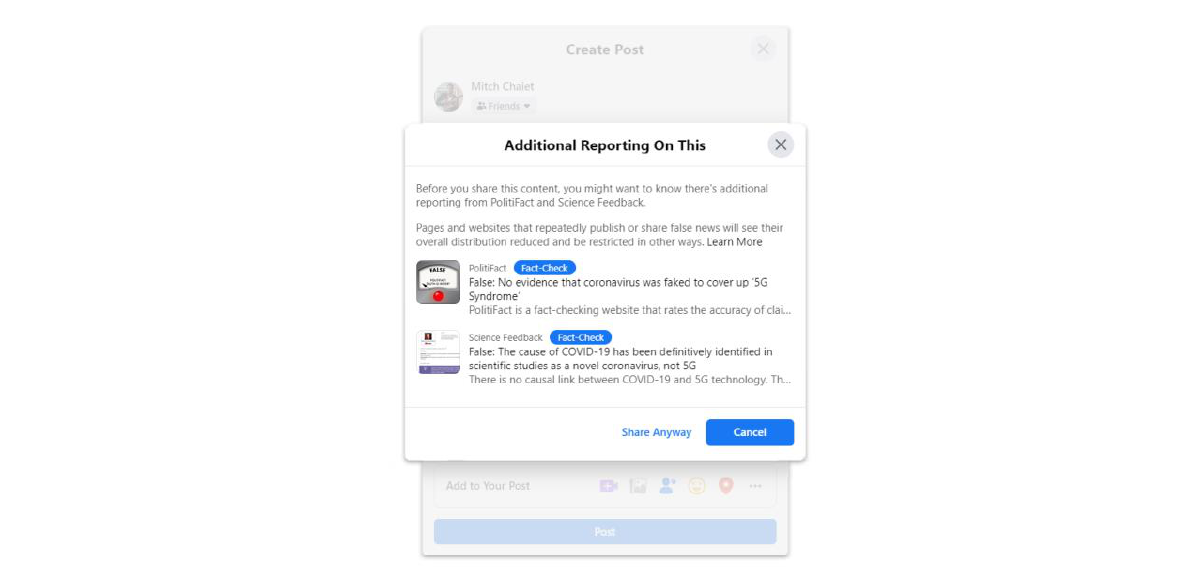
Figure 3. Facebook Fact- Check dialog that appears when posting the “CORONA HOAX” article.